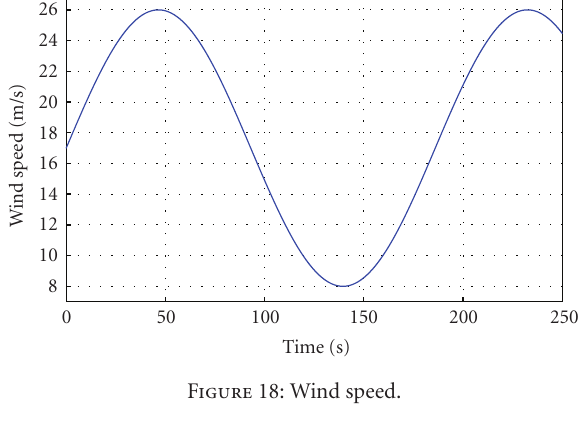
Figure 18: Wind speed.